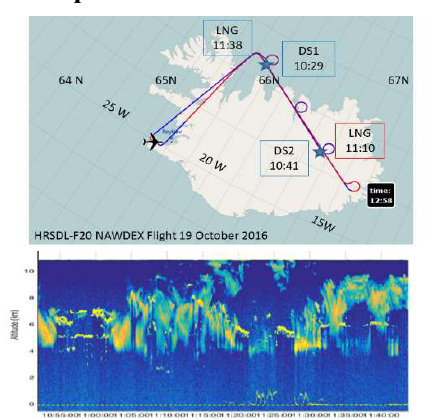
Fig. 3 : Flight plan and circle (top) made by the F20 to perform VAD measurements with LNG in vertical